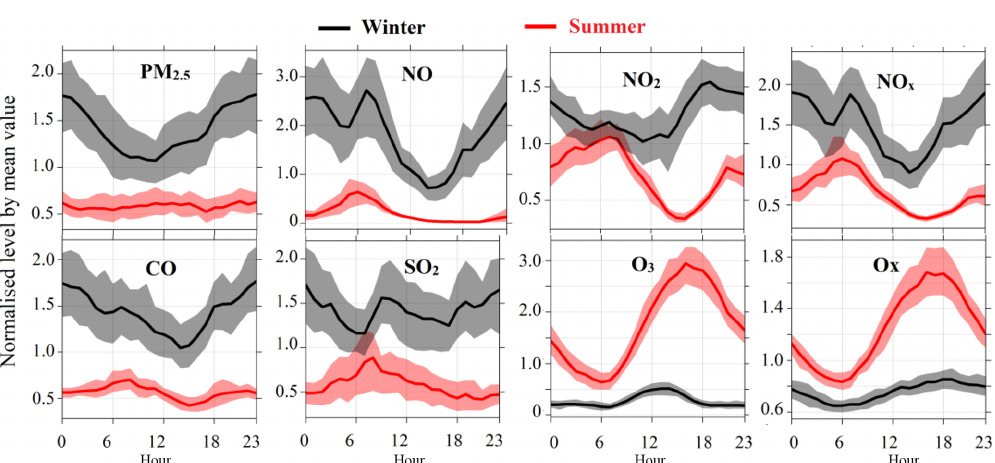
Figure 6. Diurnal patterns of gaseous pollutants normalised by average concentrations at IAP during winter and summer campaigns. The line shows the mean concentrations and shaded area as 95% confidence interval in the difference in mean